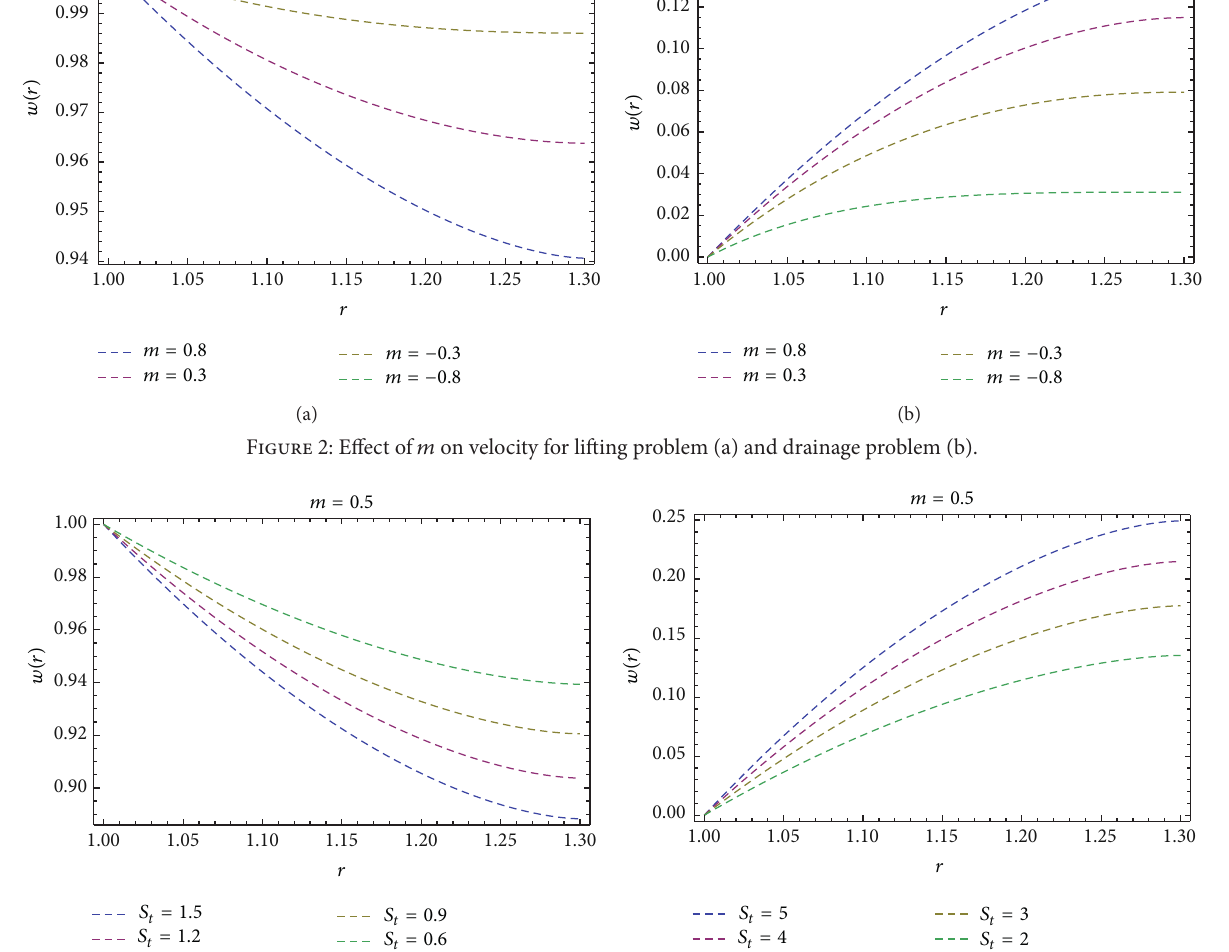
Figure 3: Effect on shear thickening fluid of 𝑆 𝑡 number on velocity for lifting problem (a) and drainage problem (b).